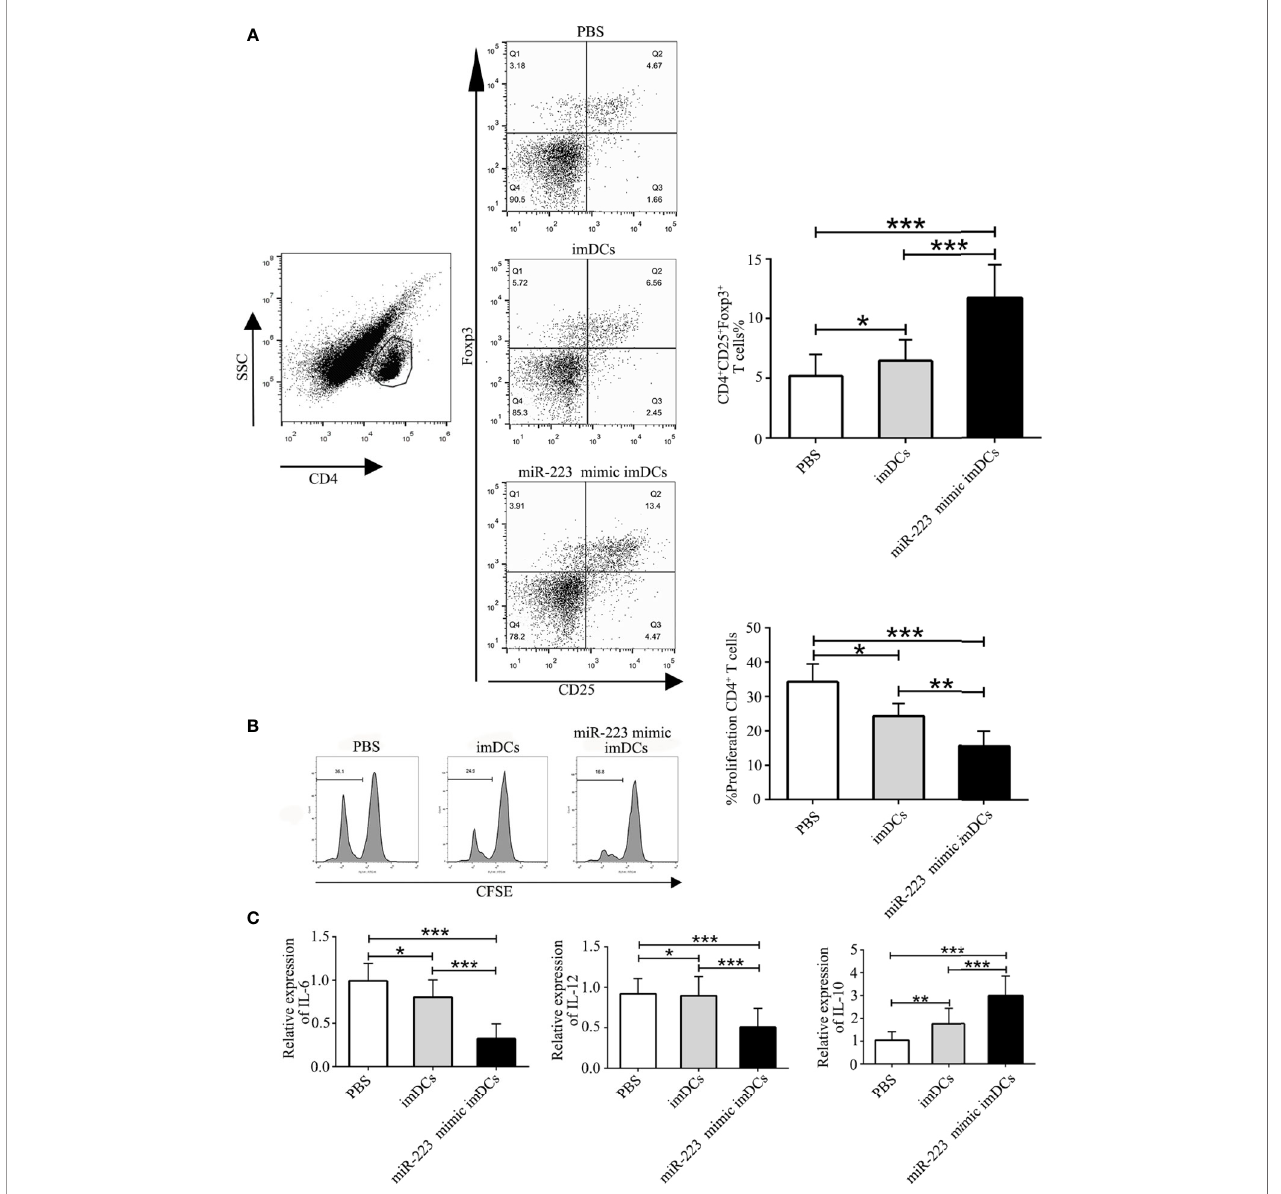
FIGURE 7 | MiR-223-overexpressing DC induces Tregs and the anti-in fl ammatory cytokine IL-10 in vivo . To elucidate the mechanisms underlying miR-223- overexpressing BMDC modulation of heart allograft rejection in vivo , splenocytes were isolated from recipient mice 7 days after transplantation and stained with fl uorescein-labeled antibodies (CD4, CD25, Foxp3), and subsequently analyzed by fl ow cytometry. (A) An increased proportion of Tregs was observed in miR-223- overexpressing BMDCs. Splenocytes (2 × 10 6 ) harvested from recipient mice of three groups and then stained with CFSE were responders, and splenocytes (6 × 10 6 , 3:1) from C57BL/6 mice treated with mitomycin C were stimulators. (B) In co-cultured T cells, T-cell proliferation was assessed by fl ow cytometry. (C) Levels of IL-6, IL-12, and IL-10 in heart grafts determined by RT-PCR. Data are presented as mean ± SD and represent six experiments. *P < 0.05; **P < 0.01; ***P <